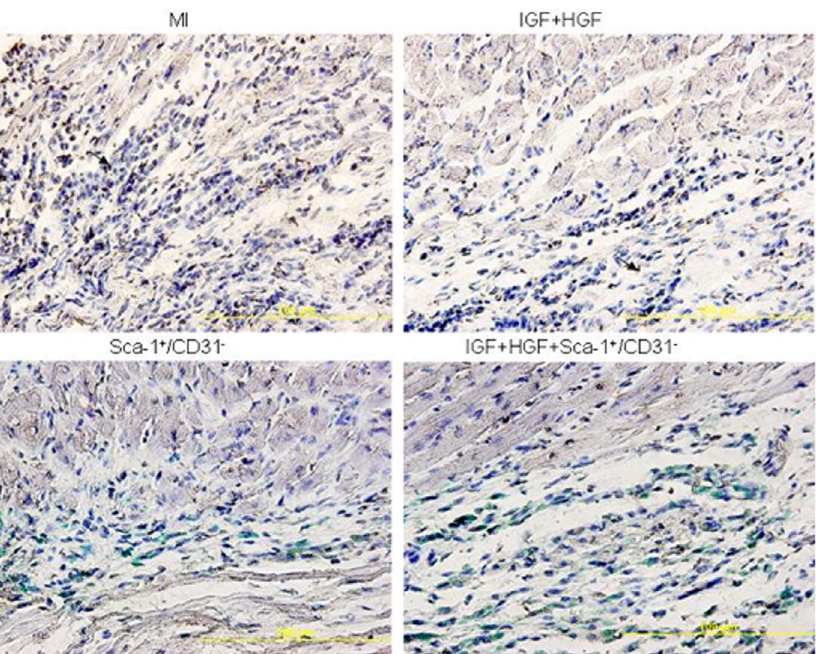
Figure 6. IGF + HGF administration is associated with decreased apoptosis (TUNEL staining) in myocardium 3 days after MI.